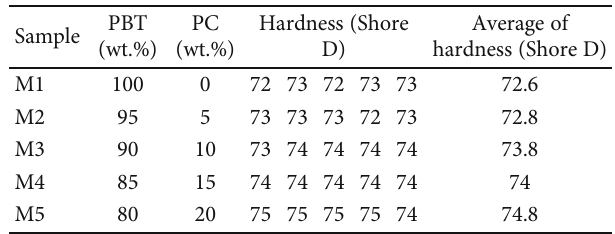
Figure 3: Flexural strength chart and fl exural strain-stress diagram. Table 3: Elastic of the fl exural testing. Table 4: The average hardness of test